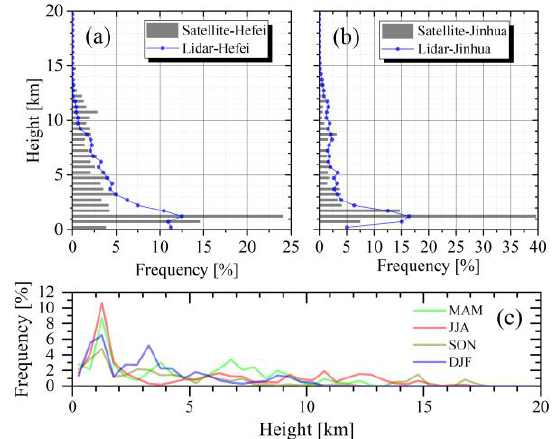
Figure 7. Occurrence frequency of cloud base height measured by CALIPSO and CloudSat or by ground-based lidar: (a) Hefei site; (b) Jinhua site; (c) the standard deviations of cloud base height distribution during the four years and the grid boxes area (smaller rectangle) are shown in Figure 1.